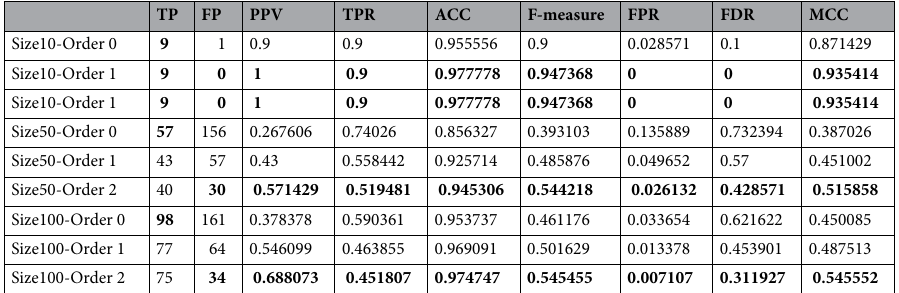
Table 3. Results for different orders of OIPCQ algorithm for DREAM3-Yeast1 of size10, 50 and 100. Best results are indicated in